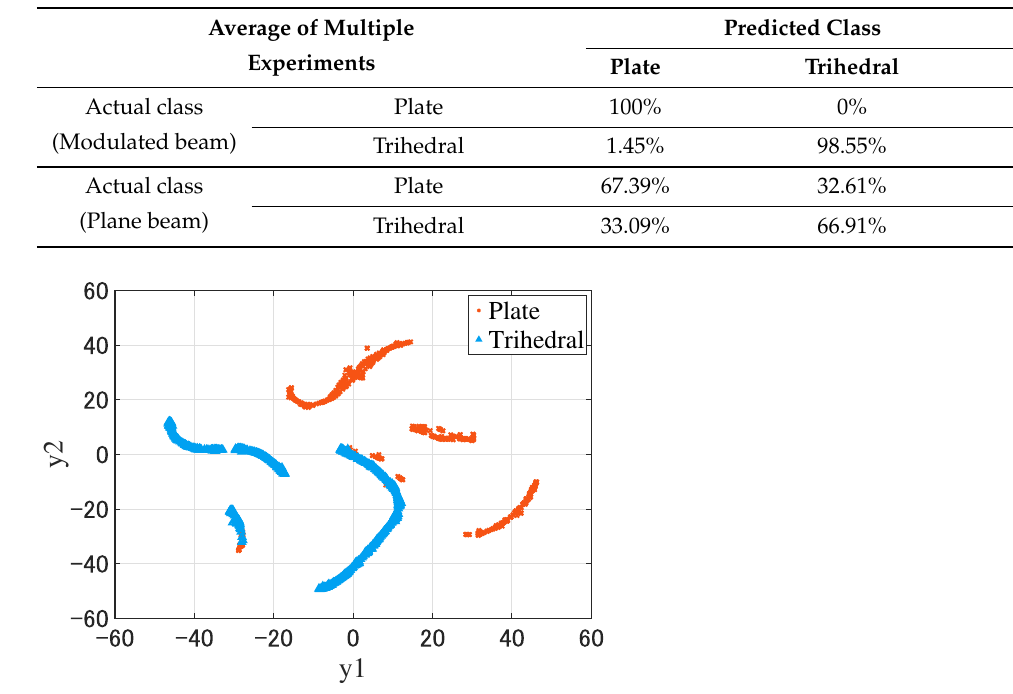
Figure 9. The visualization of the features of the plates and trihedral corner reflectors after dimen- sionality reduction (the number of data is 1386).